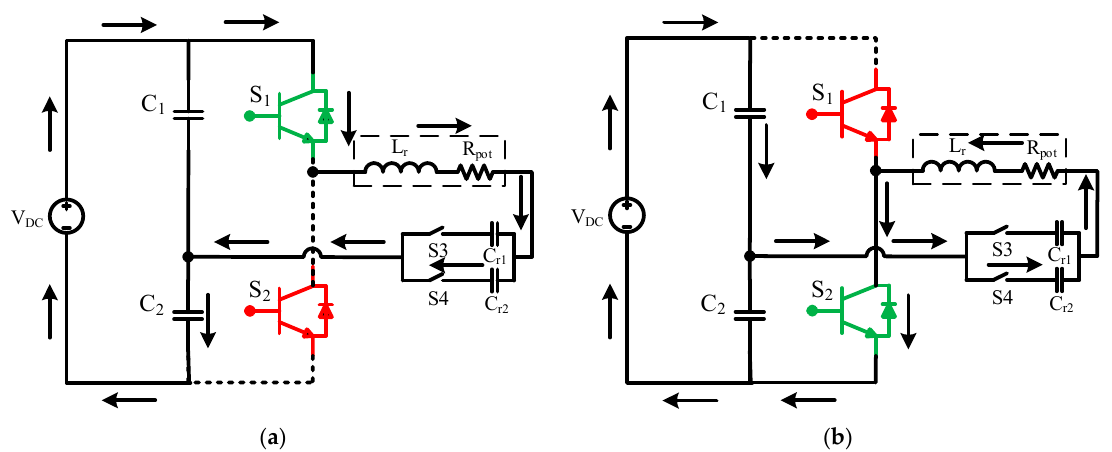
Figure 7. Circuit diagrams for non-ferrous heating mode: ( a ) S1 in ON state; ( b ) S2 in ON state.